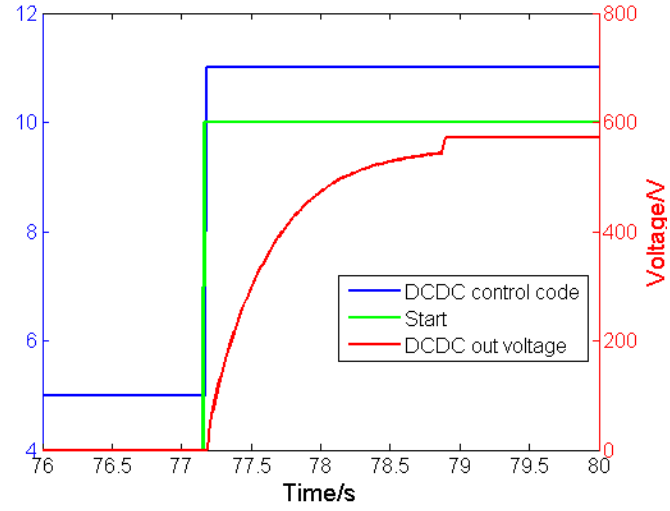
Figure 10. The voltage trend of the DC/DC during start ‐ up process.